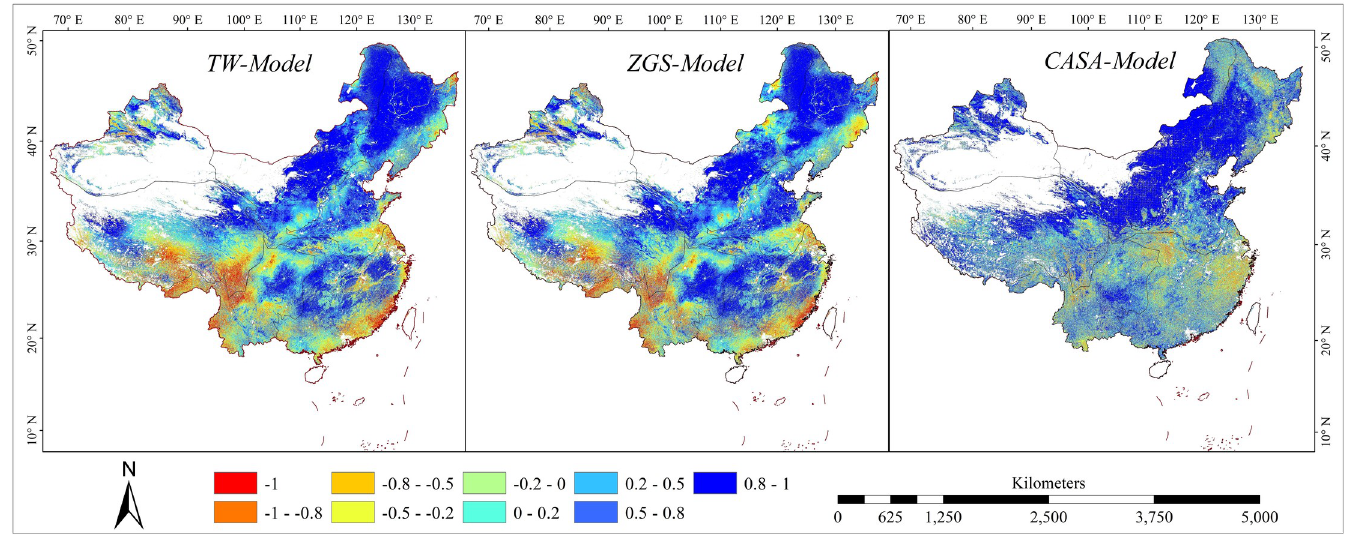
Fig 9. The spatial distribution of CC in three models compared with MODIS NPP